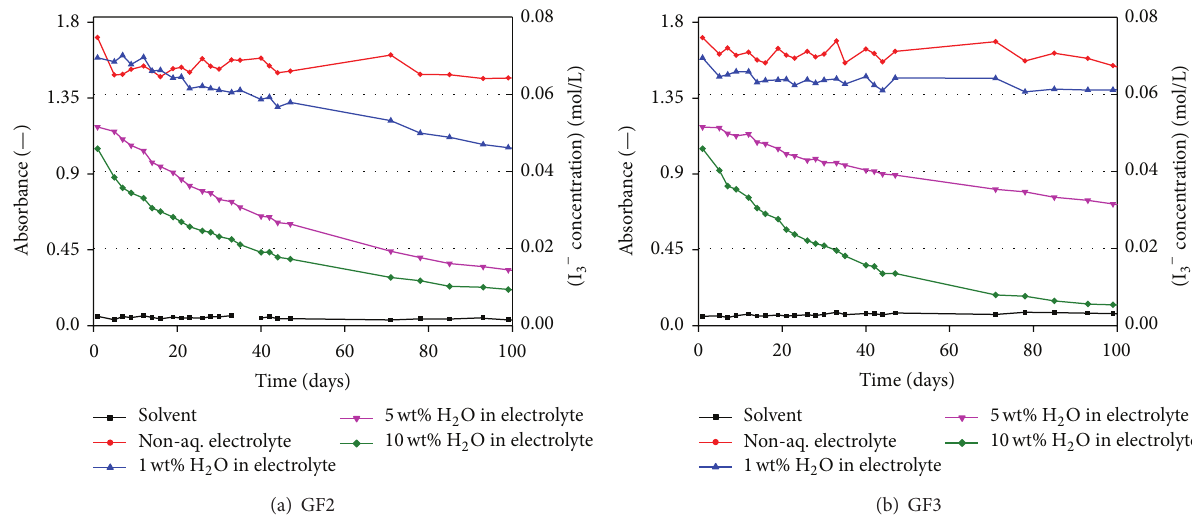
Figure 5: Absorbance at 430 nm as a function of time for the test cells filled with solvent, nonaqueous redox electrolyte, and redox electrolyte with 1, 5, and 10wt% H 2 O. (a) Test cell with GF2. Absorbance decreases over time for cells with 1, 5, and 10wt% H 2 O in electrolyte. (b) Test cell with GF3. Absorbance decreases over time for cells with 5 and 10wt% H 2 O in